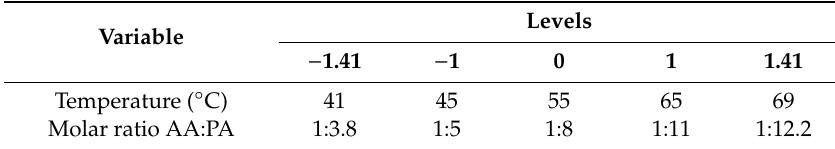
Table 5. Variables and levels selected of the synthesis of ascorbyl palmitate evaluated for a composite central